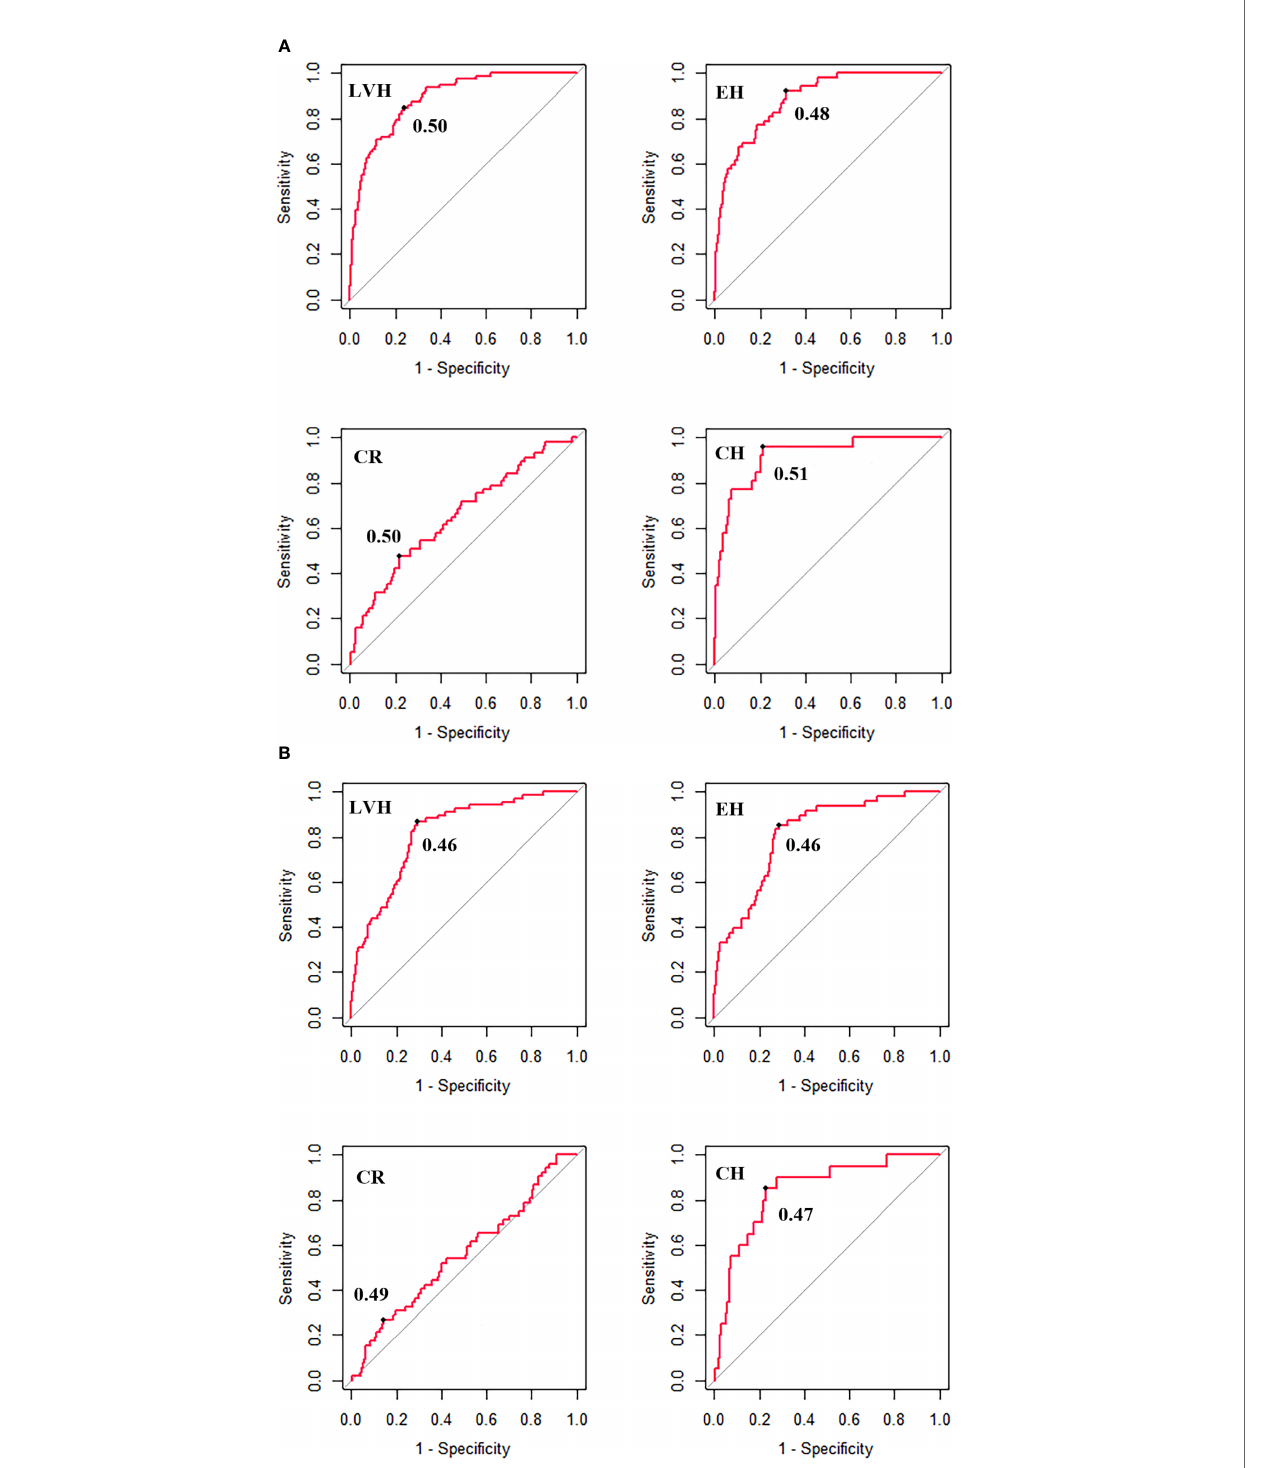
FIGURE 3 | The optimal cut-off of WHtR for identifying left ventricular hypertrophy and left ventricular geometric remodeling for boys (A) and girls (B) . LVH, left ventricular hypertrophy; CR, concentric remodeling; EH, eccentric hypertrophy; CH, concentric hypertrophy; BMI, body mass index; WC, waist circumference; WHtR, waist-to-height ratio. The optimal cut-off is the threshold corresponding to the maximum of Youden Index (sensitivity + speci fi city